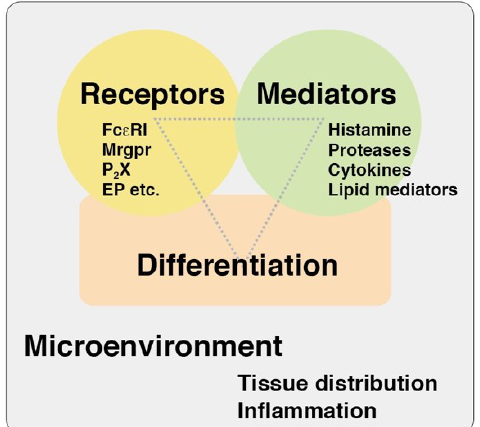
Figure 1. A viewpoint of mast cell research. Three viewpoints, such as differentiation states, expression patterns of the receptors, and capacities of the mediator release, might be useful for the comprehensive understanding of functions of tissue mast cells. Mrgpr, Mas-related G protein-coupled receptor; P 2 X, purine ionotropic receptor; EP, prostaglandin E receptor.